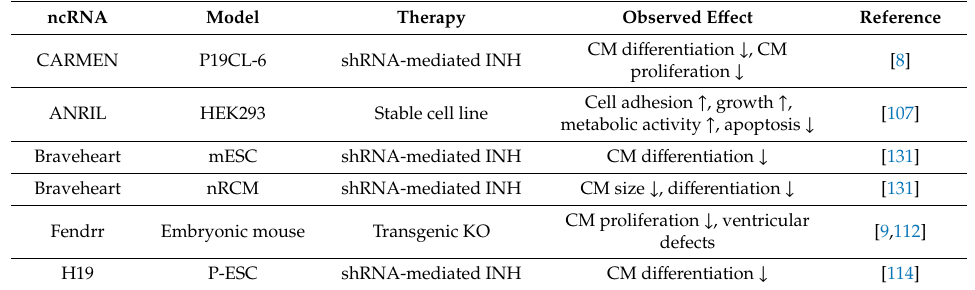
Table 2. Long noncoding RNAs regulating cardiac regeneration through control of